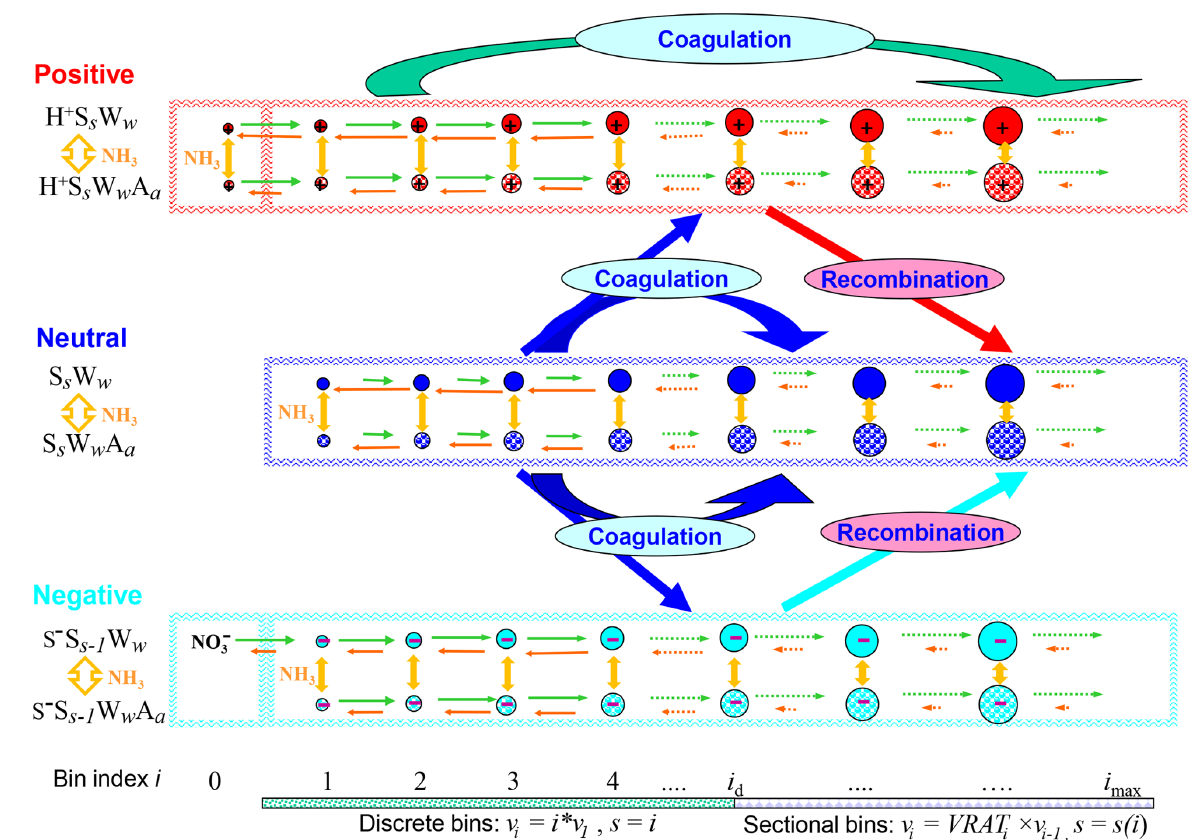
Figure 1. Schematic illustration of kinetic processes controlling the evolution of positively charged (H + S s W w A a ), neutral (S s W w A a ), and negatively charged (S − S s − 1 W w A a ) clusters–droplets that are explicitly simulated in the ternary ion-mediated nucleation (TIMN) model. Here S, W, and A represent sulfuric acid (H 2 SO 4 ), water (H 2 O), and ammonia (NH 3 ), respectively, while s , w , and a refer to the number of S, W, and A molecules in the clusters–droplets, respectively. The TIMN model has been extended from an earlier version treating binary IMN (BIMN) by adding NH 3 into the nucleation system and using a discrete-sectional bin structure to represent the sizes of clusters–particles starting from a single molecule up to background particles larger than a few